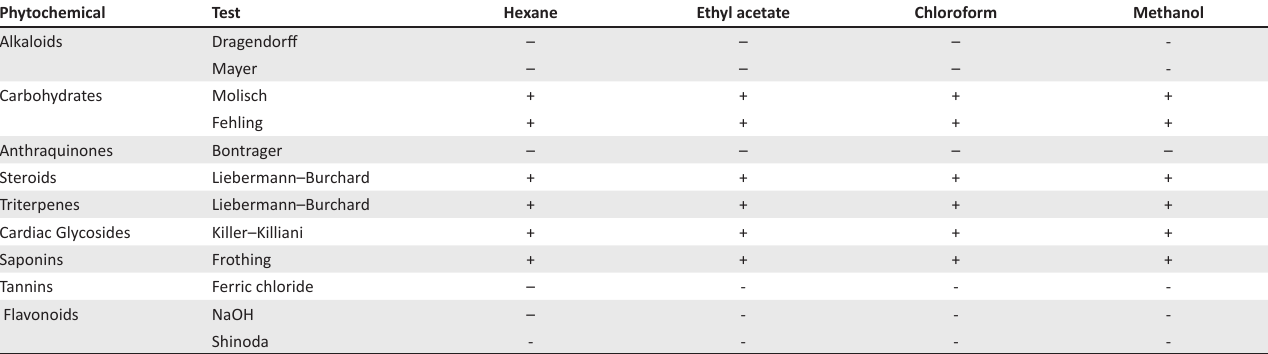
TABLE 1: Phytochemical constituents of the roots of Portulaca oleracea .